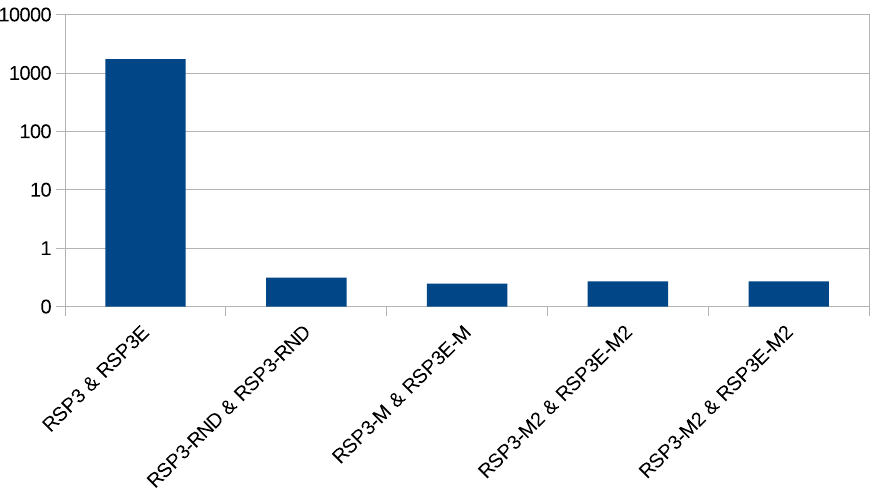
Figure 6. Average distance computations (in millions).